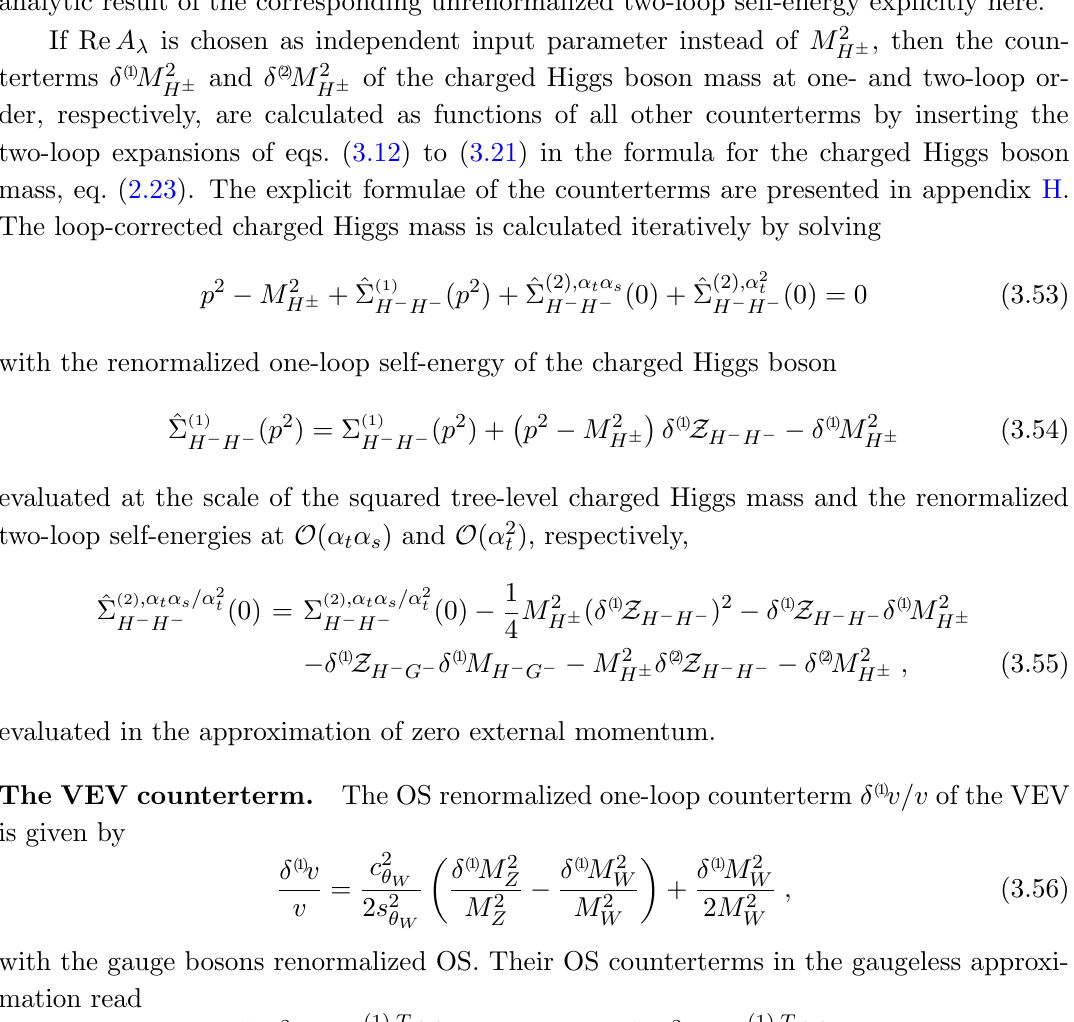
Figure 4 . Generic one-loop self-energies of the charged Higgs bosons contributing at O ( (cid:11) t ) for the renormalization of M 2 . A summation over the index a = 1 ; 2 of the internal stops is implicit. H (cid:6) of the mass of the charged Higgs boson also involves the (cid:12)eld renormalization constants. The two-loop O ( (cid:11) 2 ) contributions to the unrenormalized charged Higgs self-energies are t depicted in (cid:12)gure 15 in appendix A.2. Due to its lengthy structure, we do not display the analytic result of the corresponding unrenormalized two-loop self-energy explicitly